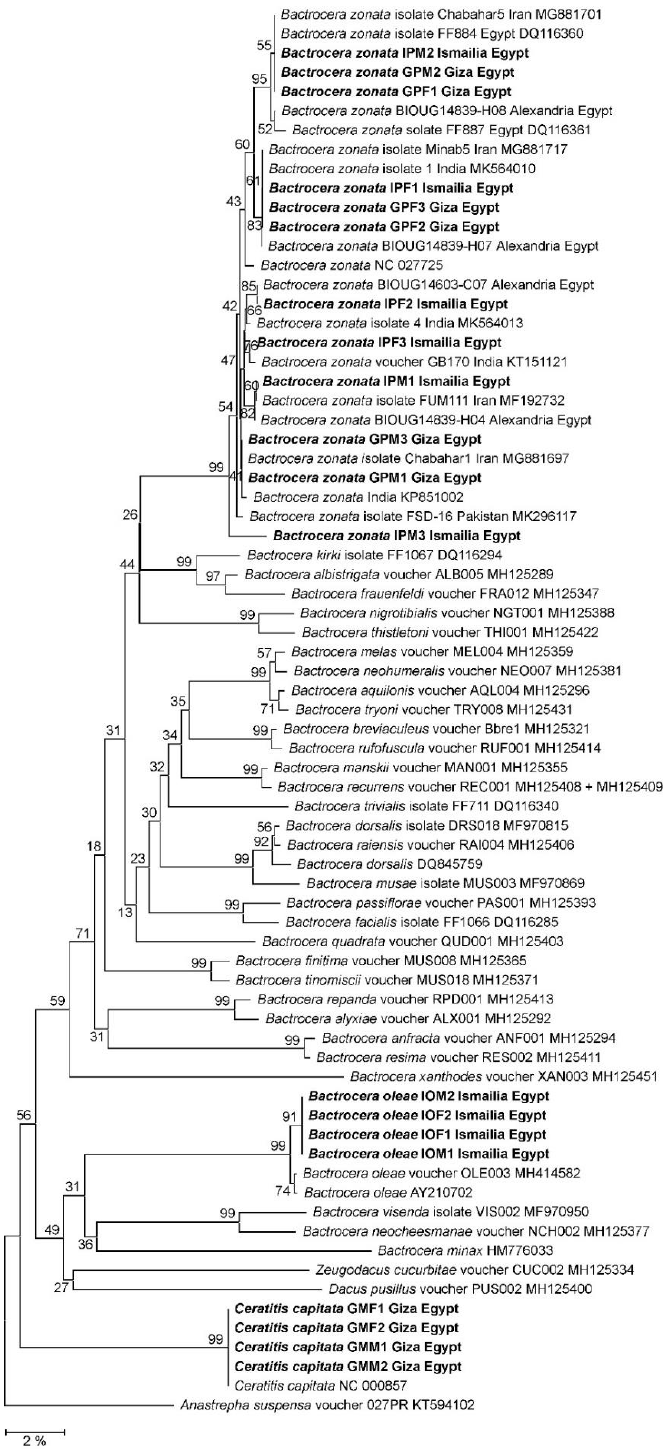
Figure 3. Neighbor Joining (NJ) phylogeny of fruit flies of the genus Bactrocera as reconstructed from mitochondrial genes encoding cytochrome c oxidase subunit 1 (COI). Terminal branches are labelled by genus, species, specimen, geographic origin designations, and Genbank accession numbers (for reference sequences). Sequences from the present study are displayed in bold type. Numbers on internal branches designate bootstrap support percentages. The size bar indicates a branch length corresponding to 2% sequence divergence. The orthologous sequence from the Caribbean fruit fly, Anastrepha suspensa , was used as outgroup.